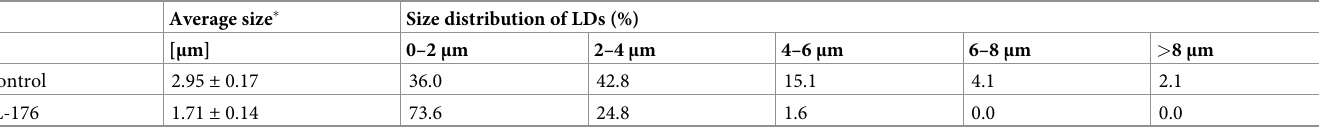
LD size distribution in 3T3-L1 cells. LD diameters were calculated by Image J. � The average size of lipid droplet represents the mean ± S.D.